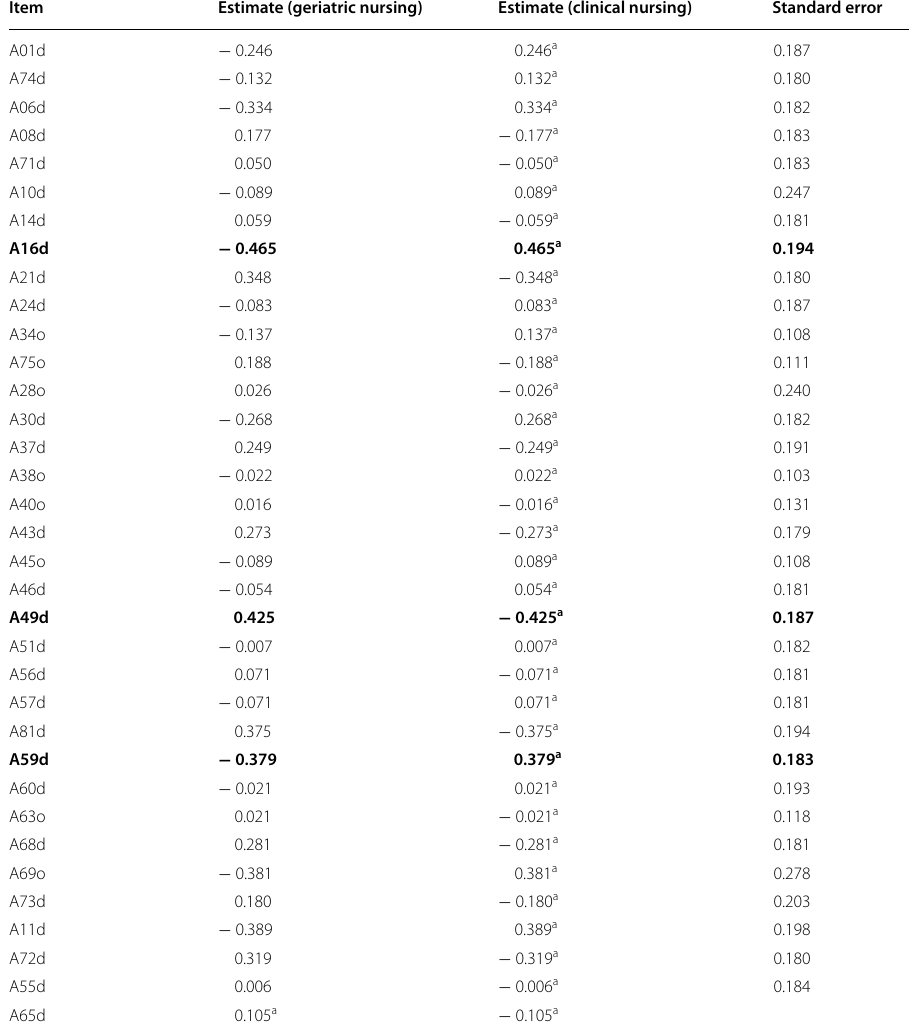
Table 19 DIF item analysis to identify subgroup invariance between specializations at the item level for measurement in the third